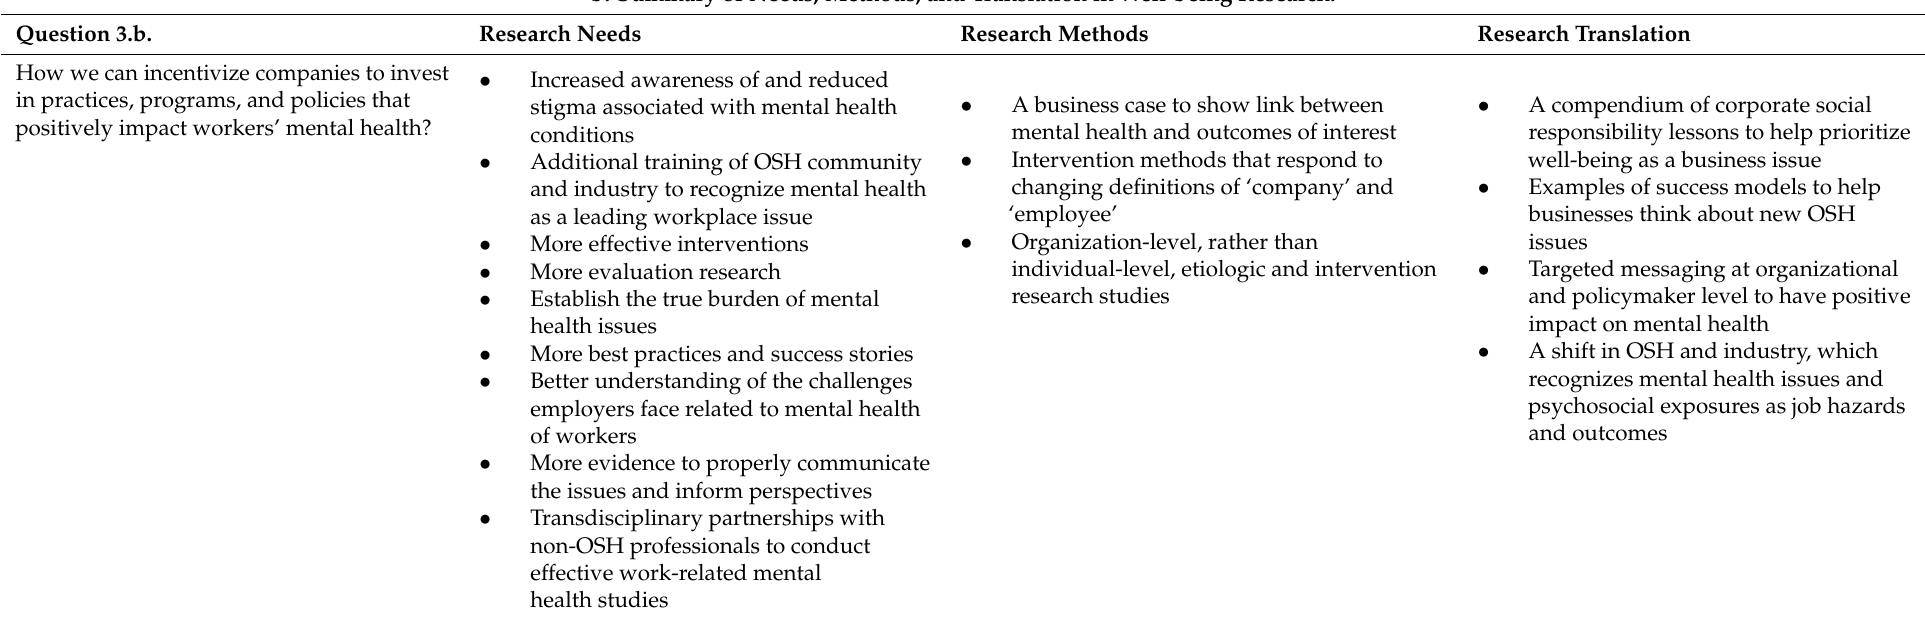
Table 2. Cont. b. Summary of Needs, Methods, and Translation in Well-being